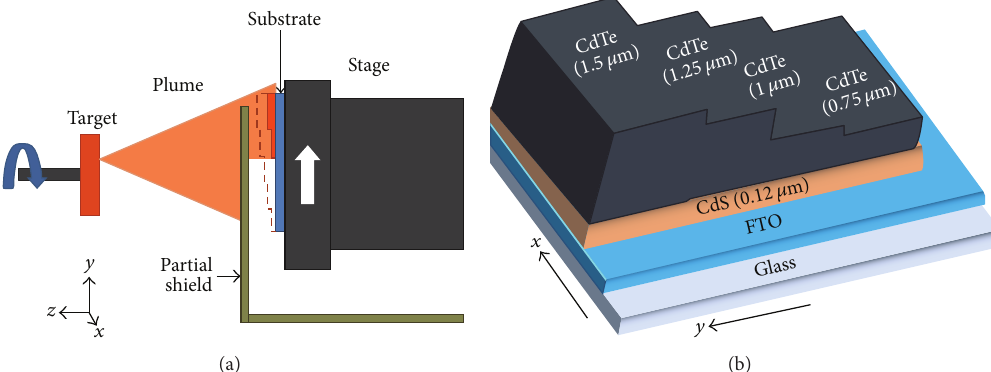
Figure 1: A depiction of the combinatorial PLD process which allows different thicknesses to be deposited on a single substrate (a) and a schematic drawing of the samples made with varying CdTe thickness